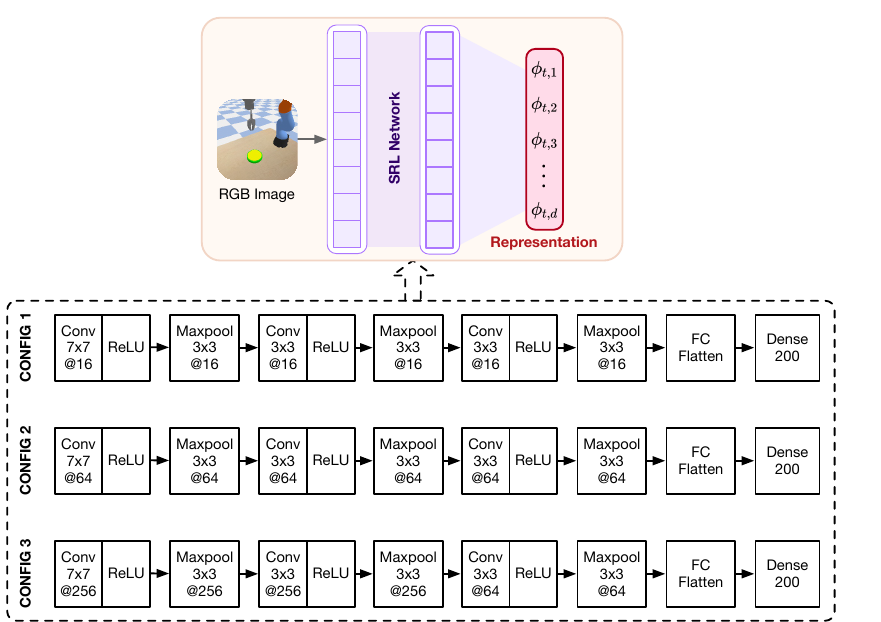
Figure 4. Three sets of hyperparameter configurations of the encoding network with increasing trainable parameters. The input image is encoded using the pre-trained encoder to obtain the latent representation, which the RL agent then uses to output the actions.